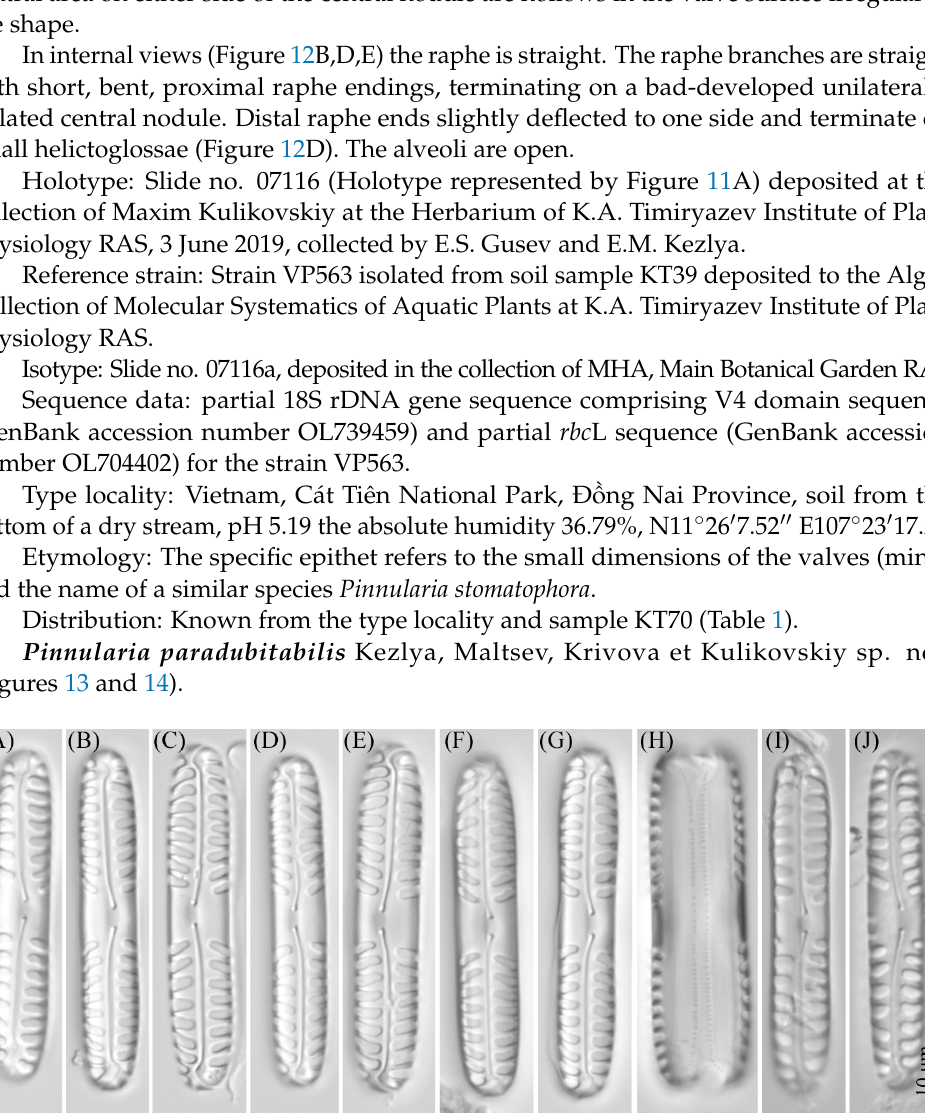
Figure 13. Pinnularia paradubitabilis Kezlya, Maltsev, Krivova et Kulikovskiy sp. nov. Strains VP563 slide No. 07116. Light microscopy, differential interference contrast. ( A – G ) Valve face. ( A ) Holotype. ( H ) С ell in girdle view. ( I – K ) Valves from the wild sample. Ultrastructure: In external views, the raphe branches are straight or broadly rounded,